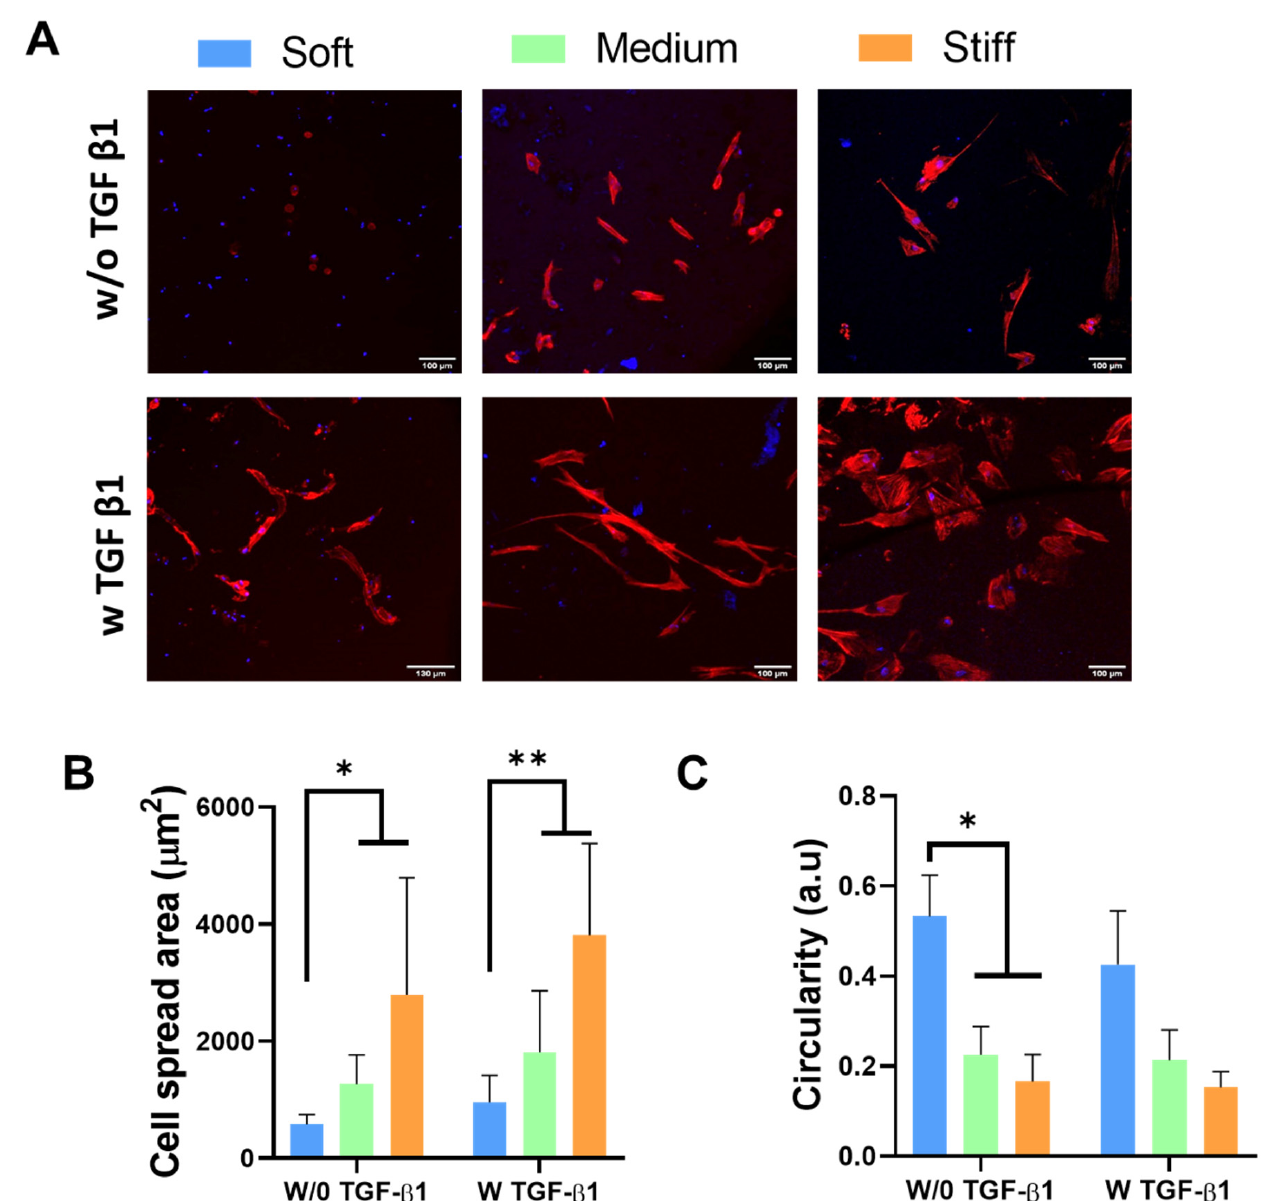
Figure 2. Effect of increasing GelMA hydrogel stiffness on ( A ) cell morphology, ( B ) cell spread area and ( C ) cell circularity. * p < 0.05 compared to the soft GelMA hydrogel in the absence of TGF- β 1; ** p < 0.05 compared to the soft GelMA hydrogel in the presence of TGF- β 1.